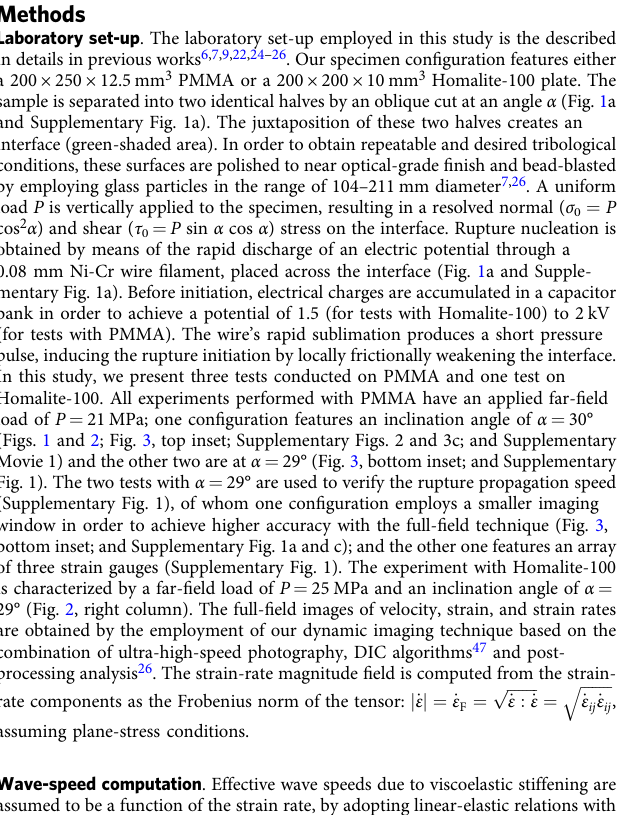
Fig. 1b, horizontal dashed line). Two nominally identical experiments have been